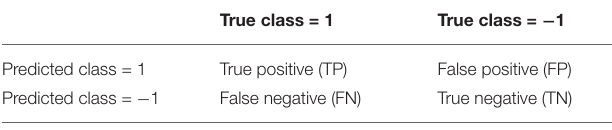
TABLE 1 | Confusion matrix of a binary